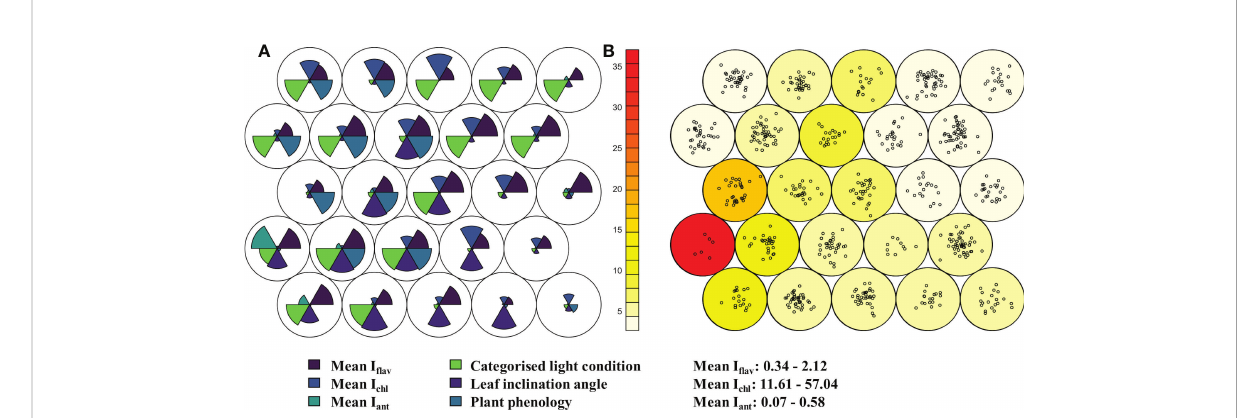
FIGURE 1 Relative differences in leaf traits from 672 taxa in the alpine botanical garden (Col du Lautaret, France) shown in a hexagonally arranged Kohonen self-organising map (SOM) with 25 nodes. Plants were sampled for optically measured leaf traits; indices of adaxial fl avonol/ fl avone (I fl av , dark blue, above right wedge) and anthocyanin (I ant , turquoise, above left wedge), and leaf chlorophyll (I chl , blue, above middle wedge) during the summer of 2014. Panel (A) shows the relative differences (radius of each wedge) in three scaled mean leaf traits in the upper half circle. The lower half circle contains relative differences in categorised light condition of the plants, categorised phenological advancement, and categorised leaf inclination angle. Panel (B) shows loadings of the nodes i.e., number of taxa grouped in the node as points, and neighbour distance (sum of distances to all immediate neighbours) as colour scale with red for the greatest distance. These analyses allowed for distinction of different developmental stages of those species where such an approach was deemed necessary. Range in mean optically measured leaf traits among taxa are given lower